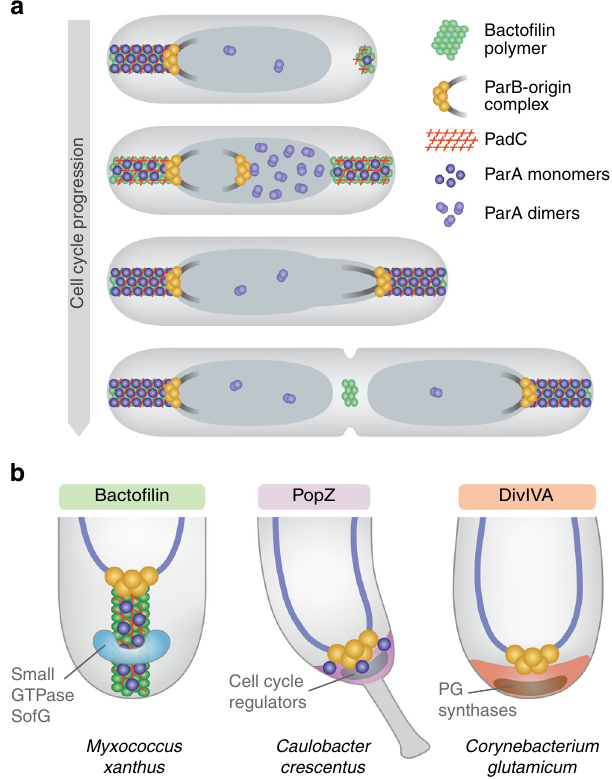
Fig. 8 Model for the function of bacto fi lins in M. xanthus . a Organization of the M. xanthus chromosome segregation machinery by bipolar BacNOP · PadC complexes. Bacto fi lin structures assemble in a cell cycle- dependent manner. They interact with the adapter protein PadC, which in turn captures ParA monomers and thus mediates their retention in the subpolar regions of the cell. The tips of the bacto fi lin structures bind to the chromosomal ParB · parS complexes, thereby ensuring the proper arrangement of the two sister chromosomes after their segregation by nucleoid-associated ParA dimers. b Comparison of the polar scaffolding proteins BacNOP from M. xanthus , PopZ from C. crescentus , and DivIVA from the actinomycete C. glutamicum . Despite their distinct evolutionary origins, all of these proteins function in the organization of the ParAB S chromosome segregation machinery. Moreover, they all interact with additional pole-associated factors, serving as multi-purpose hubs that help to spatially organize distinct cellular